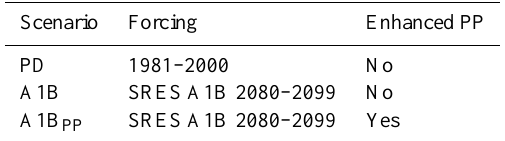
Table 1. Main characteristics of the set-up of the three scenarios.